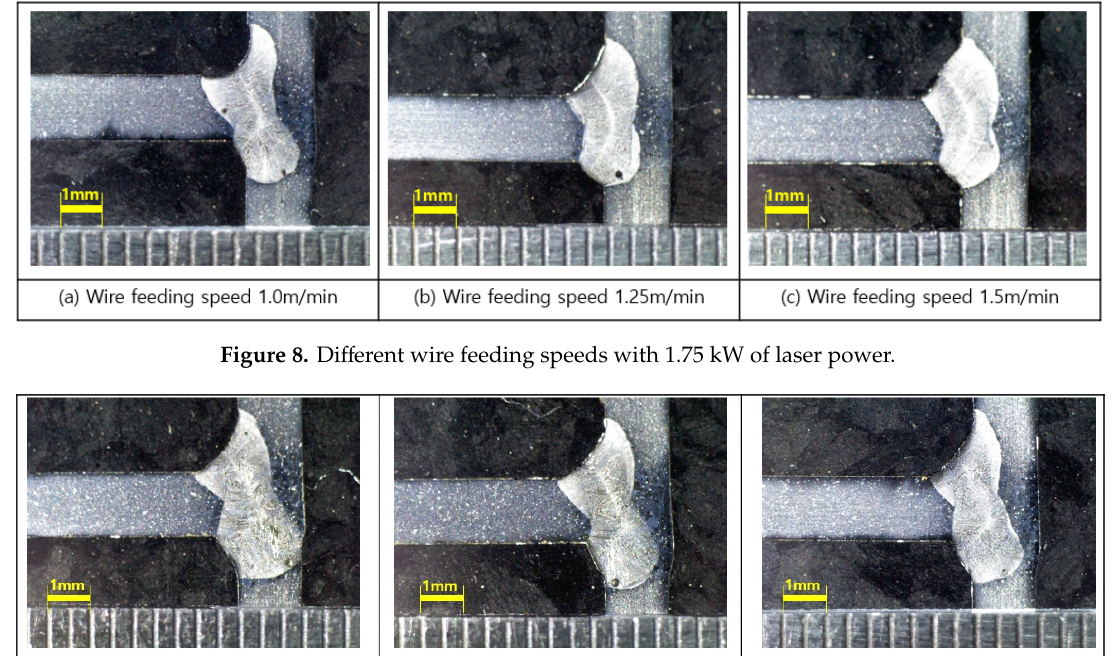
Figure 11. Applying different levels of laser power.